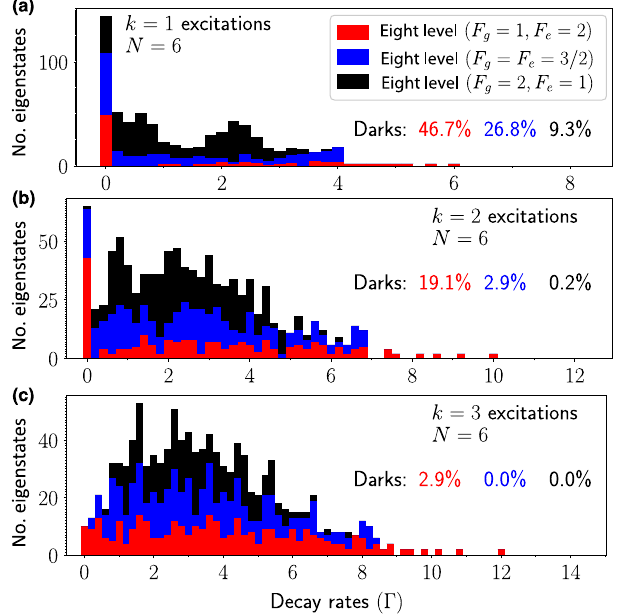
FIG. 16. Eight-level collective eigenstates. Histograms of the decay rates ( γ = Γ ) of all collective eigenstates with (a) k ¼ 1 , (b) k ¼ 2 , and (c) k ¼ 3 excitations for N ¼ 6 . We show results 1 , F 2 , (blue) for eight-level systems with (red) F g ¼ e ¼ 3 = 2 , and (black) F 2 , F 1 . We provide in F F g ¼ e ¼ g ¼ e ¼ the plots the percentage of eigenstates that are dark for each k and level structure in the associated color. Note that the histograms are stacked on top of each